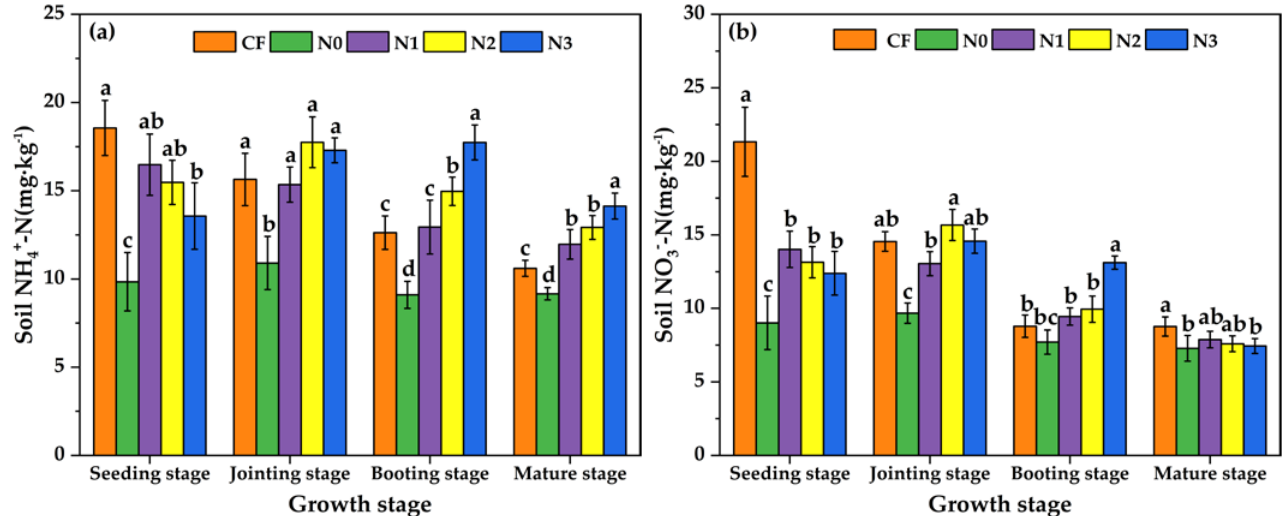
Figure 8. Changes of ( a ) soil NH 4+ -N and ( b ) soil NO 3 − -N in spring wheat fields under the different nitrogen fertilizer managements. Note: Different lowercase letters in the same seeding stage indicate significant differences among different treatments (LSD test, p < 0.05).